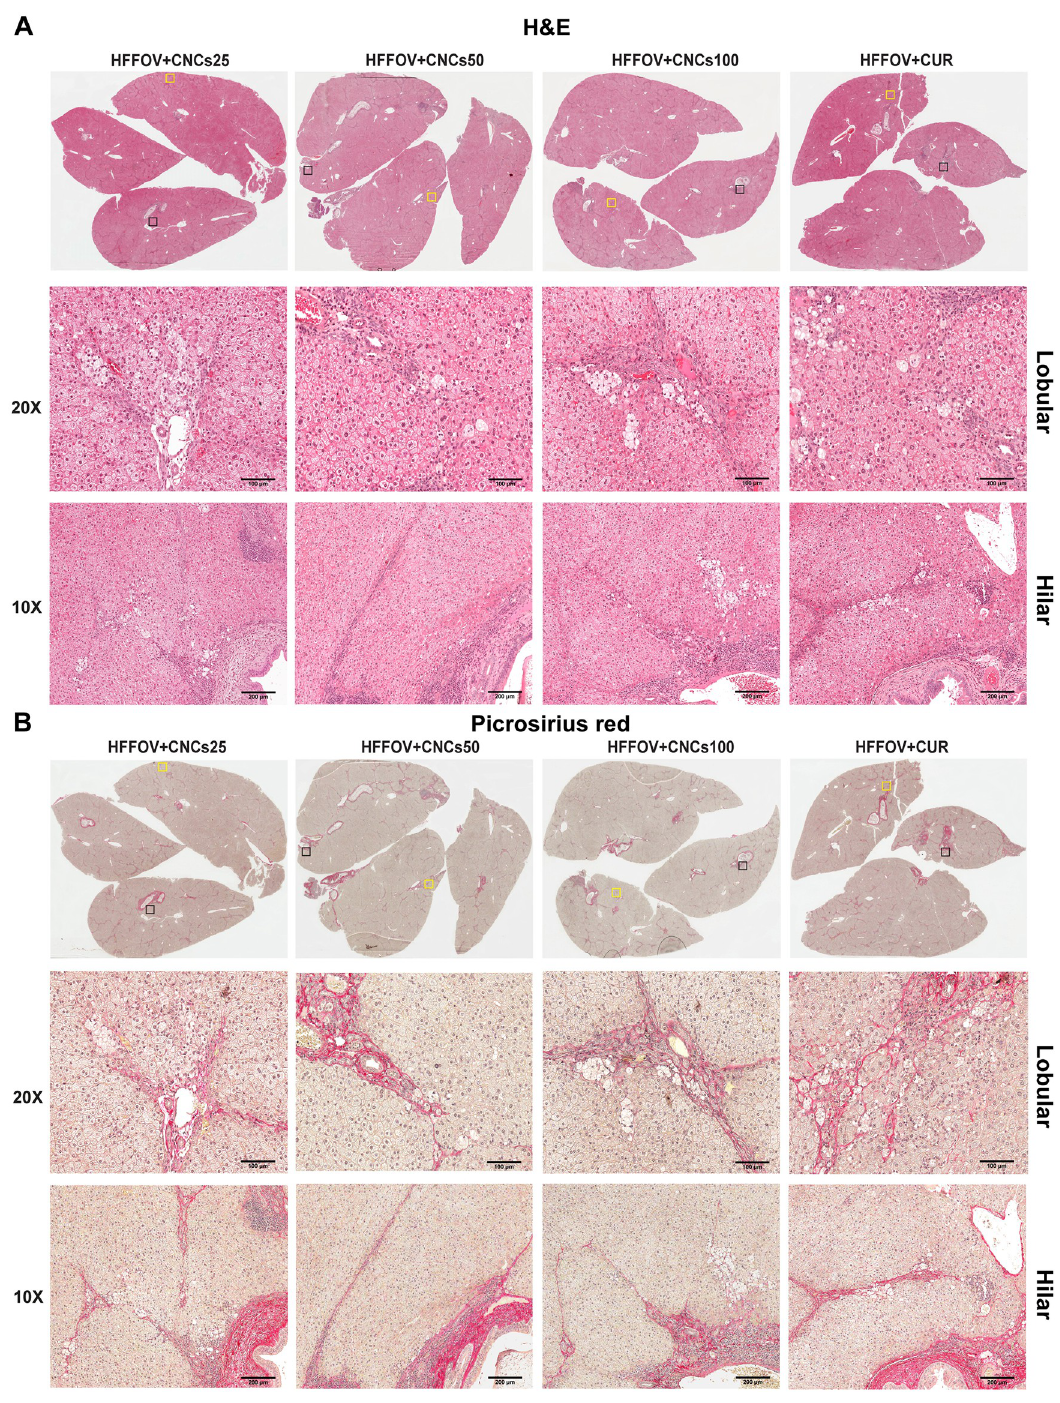
Fig 5. Histopathological changes induced by O . viverrini infection and HFF diet in experimental groups that were also treated with CNCs. A): H&E stain was used to investigate liver histopathological changes; and B): Picrosirius red stain was used to investigate fibrosis. Experimental animal groups and abbreviations are the same as in Fig 3